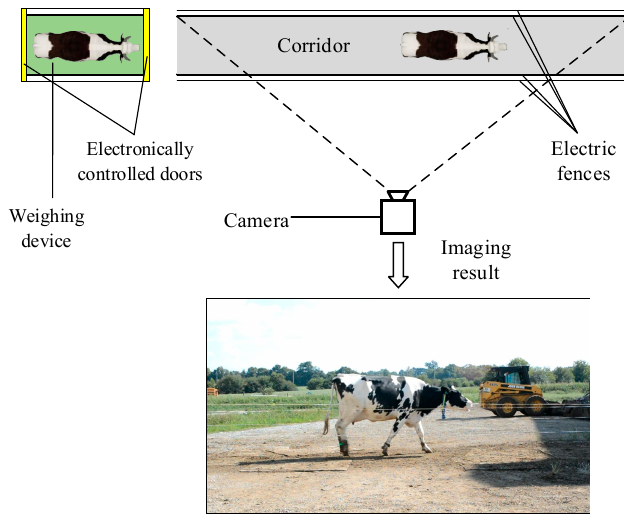
Figure 1. Diagram of the video acquisition system.